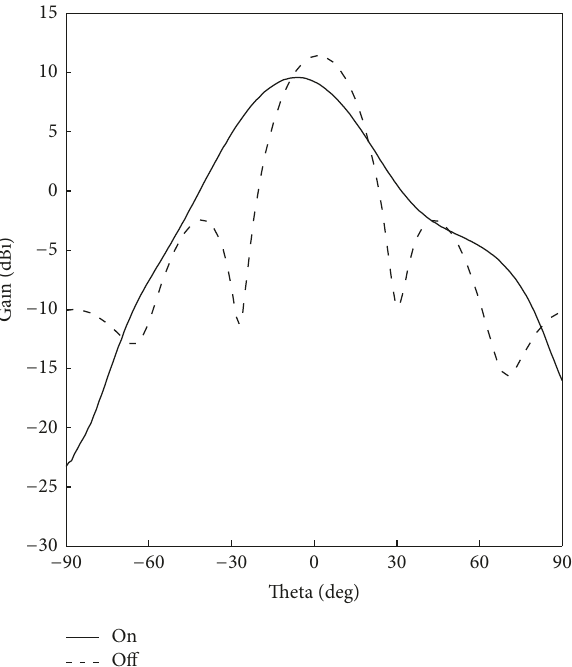
Figure 10: Measured radiation pattern of coupler using PIN diode and bias-T.